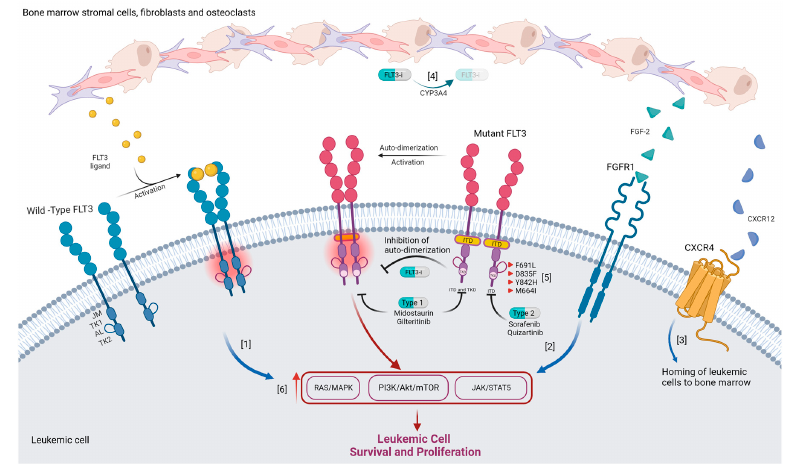
Figure 1. Mechanisms of resistance to FLT3i. 1. Increase in FLT3 ligand levels following induction chemotherapy results in increased RAS/MEK/ERK signaling following its activation of wild-type FLT3 receptor. 2. FGF-2 secreted from bone marrow stromal cells activates FGFR-1 resulting in the activation of MAPK signaling. 3. Binding of CXCR12 released by osteoblasts to CXCR4 expressed on leukemic cells promotes their homing to bone marrow. 4. Increased metabolism of FLT3i by CYP34A decreases drug efficacy. 5. On target mutations promote resistance to FLT3i: F691L mutation causes decreased drug binding, D835F and Y842H stabilize active conformation of FLT3, and M664I increases speed of downstream signaling. 6. Activating mutation in components of downstream signaling pathways contributes to cell survival and proliferation independent of FLT3 signaling.